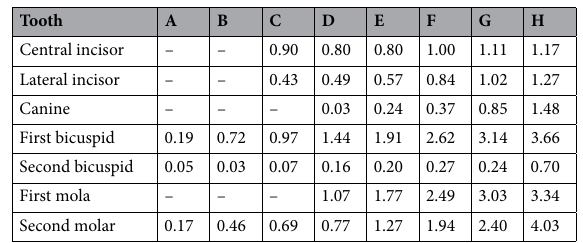
Table 3. The tooth score of the modified model (left mandibular teeth, male ).